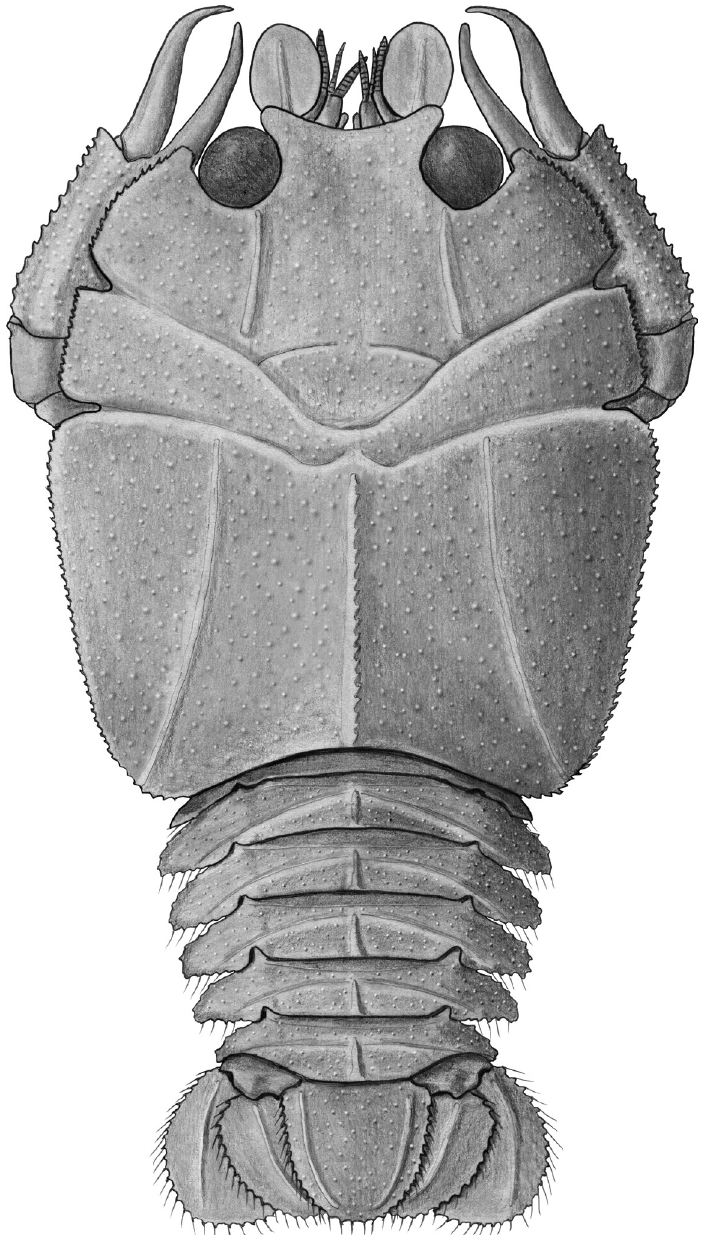
Fig. 3. Reconstruction of the dorsal aspect of Rosenfeldia triasica Garassino, Teruzzi & Dalla Vecchia, 1996. Please note that due to the preservation conditions of specimens, the precise outline of the carapace and shape of grooves are difficult to assess. Image hand-drawn by D.